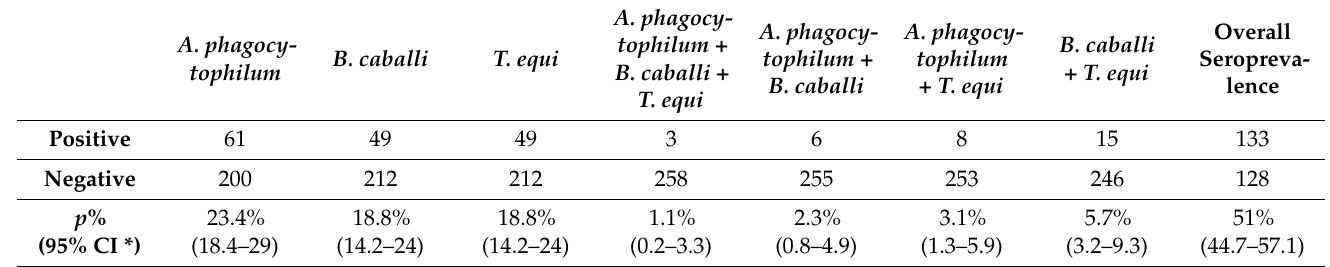
Table 1. Seropositivity to Anaplasma phagocytophilum , Theileria equi and Babesia caballi and their co-infections with IFAT in 261 horses in northern